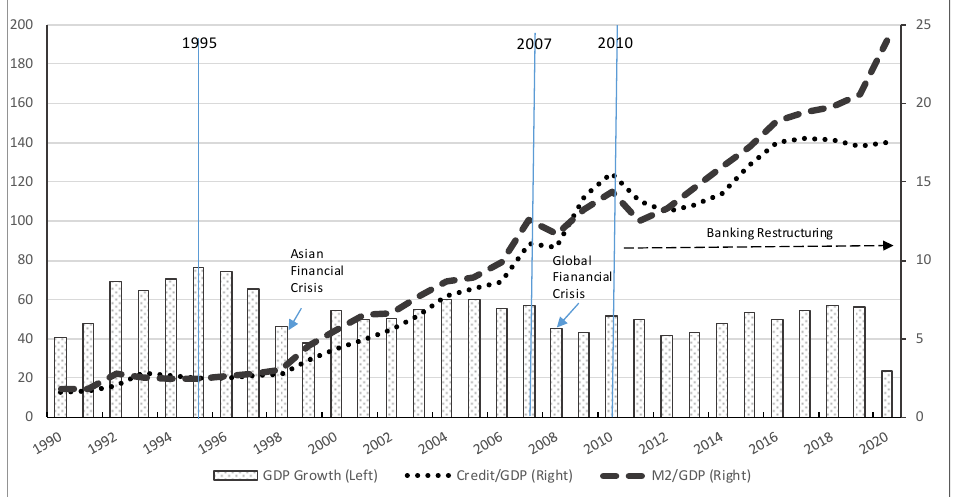
Figure 1. Banking depth and growth 1990–2020. Source: World Bank’s Open Data Bank and SBV (2021).